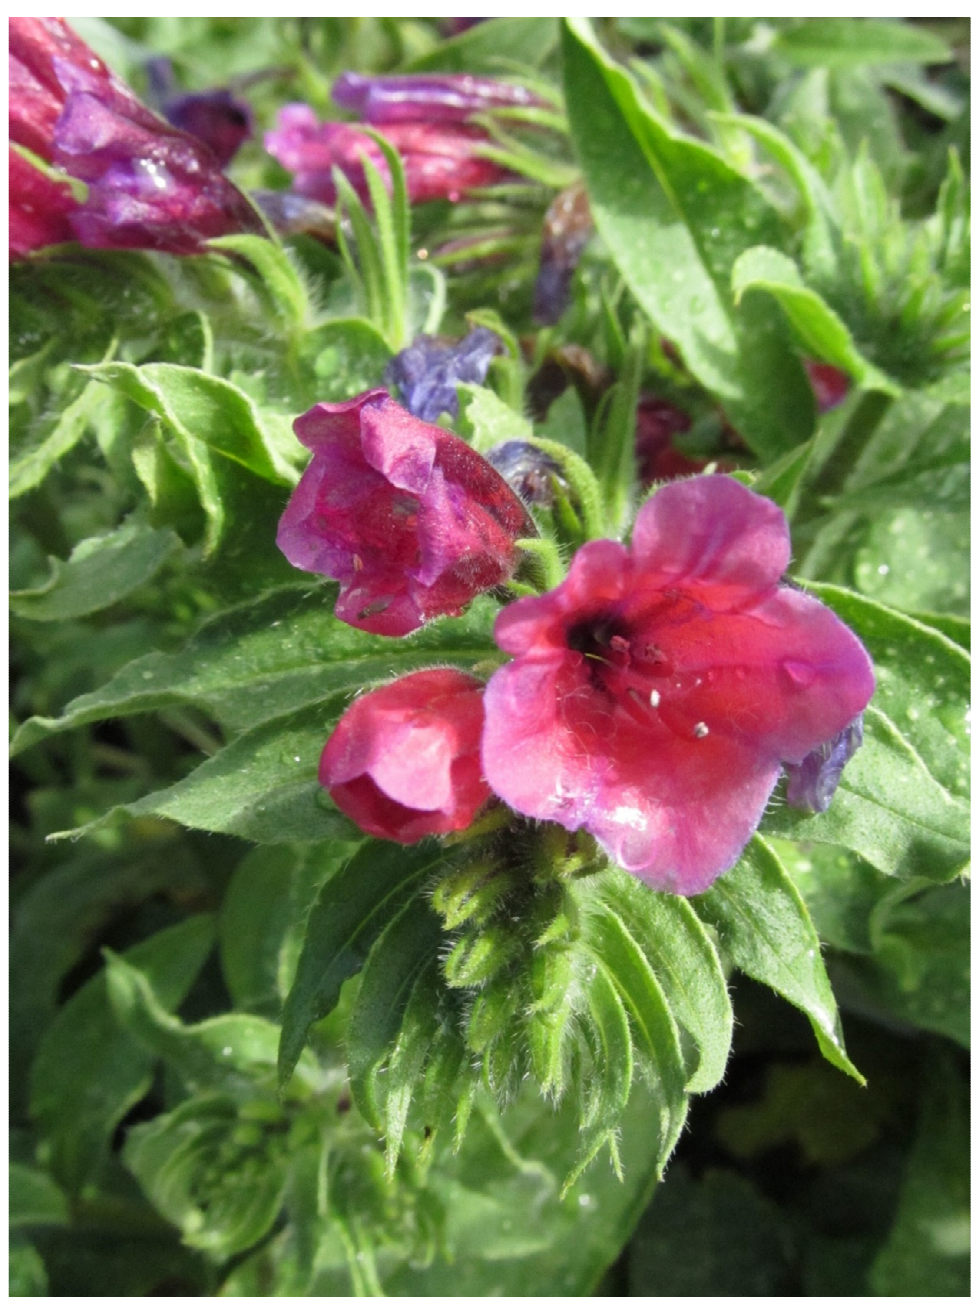
Figure 1. Echium amoenum cultivated in the Botanical Garden of the University of Bergen, Norway, photographed Friday 8 August 2014, at 10:30 a.m. Photo: Torgils Fossen.